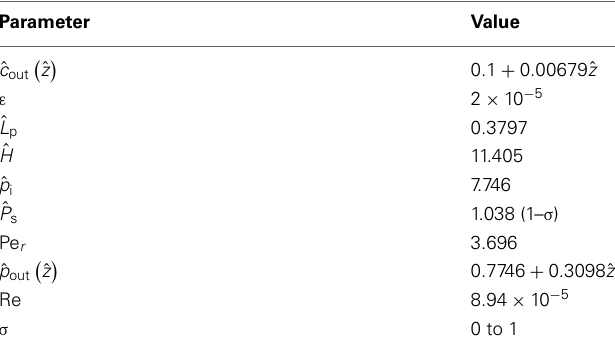
Table 2 | Values of non-dimensional physical parameters resulting from data of Table